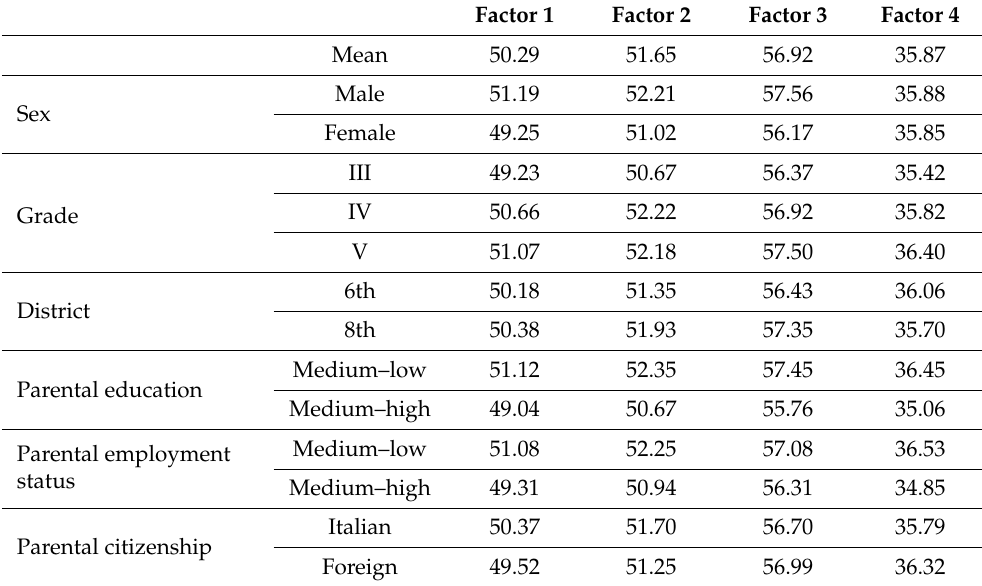
Table 2. Factors’ mean scores for structural variables.